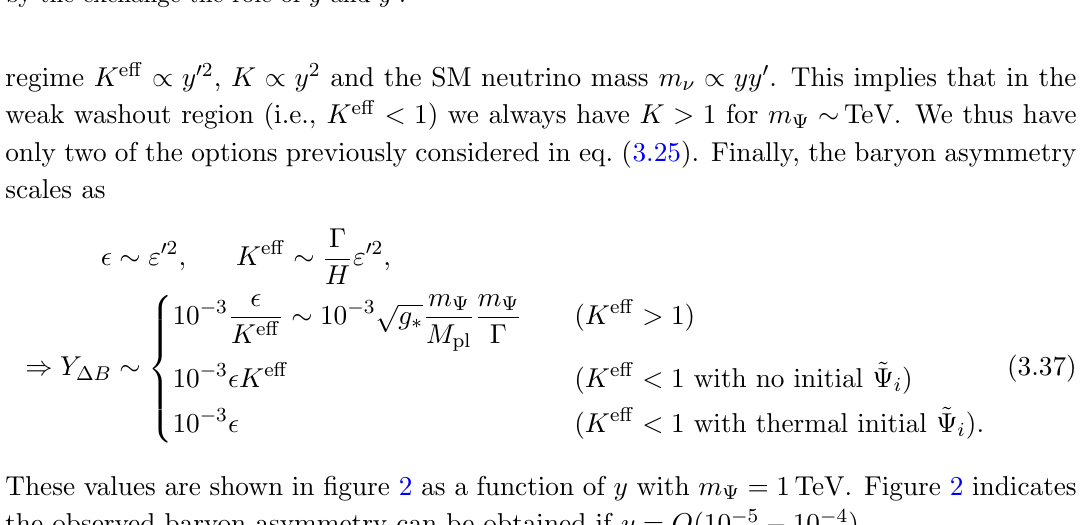
Figure 2 . The baryon asymmetry Y (cid:1) B as a function of y in the case where (cid:14) " 0 in ISS+LSS (cid:24) models. Here m (cid:9) is (cid:12)xed to be 1 TeV. The blue dashed line shows result with initial thermal abundance of ~(cid:9) i while the solid brown line shows the results with no initial ~(cid:9) i abundance. The vertical dotted lines indicate the border between the strong and weak washout regions. The orange line shows where the observed baryon asymmetry is obtained. Here we only plot the region where p 10 (cid:0) 6 . When y < y 0 , the results can be simply obtained y > y 0 , meaning y > p yy 0 m (cid:23) m (cid:9) =v 2 (cid:24) (cid:25) by the exchange the role of y and y 0